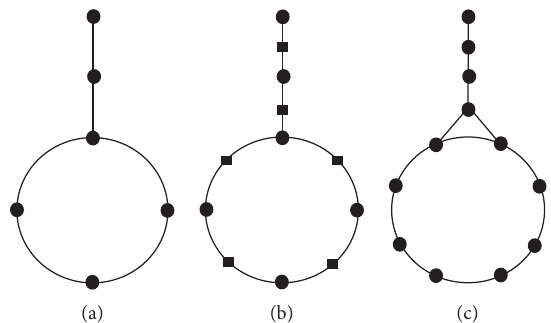
) ; (c) Paraline graph of dragon graph L ( S ( T 4 , 2